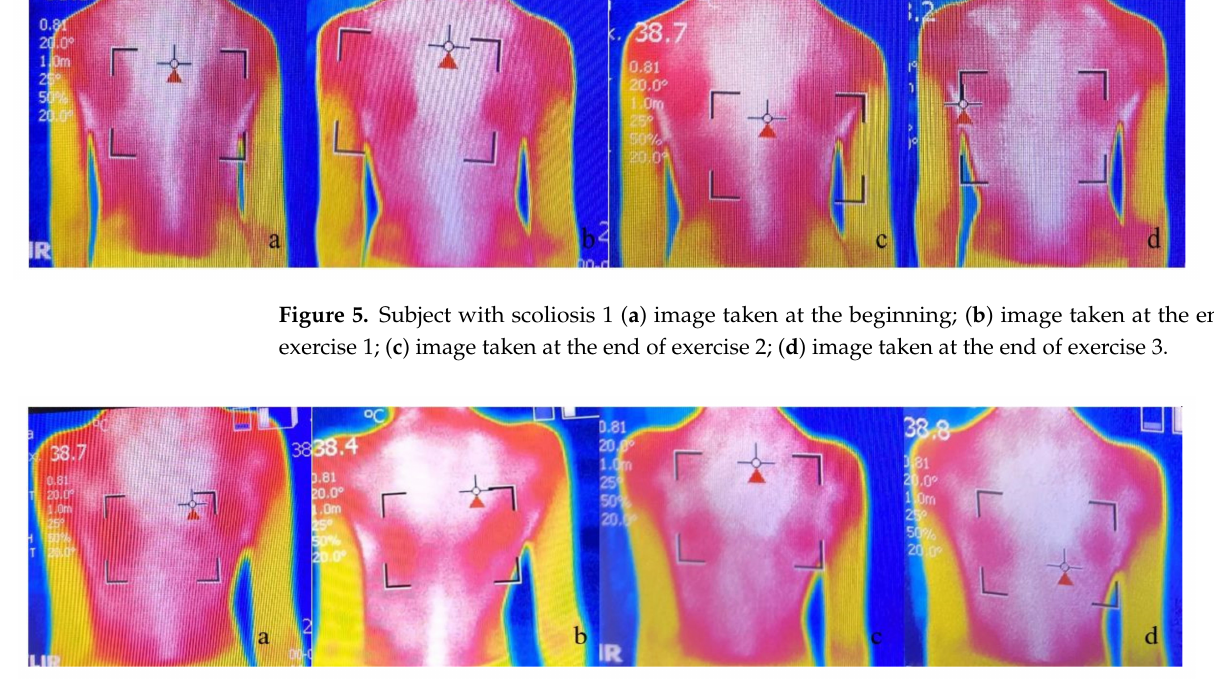
Figure 6. Subject with scoliosis 2 ( a ) image taken at the beginning; ( b ) image taken at the end of exercise 1; ( c ) image taken at the end of exercise 2; ( d ) image taken at the end of exercise 3.